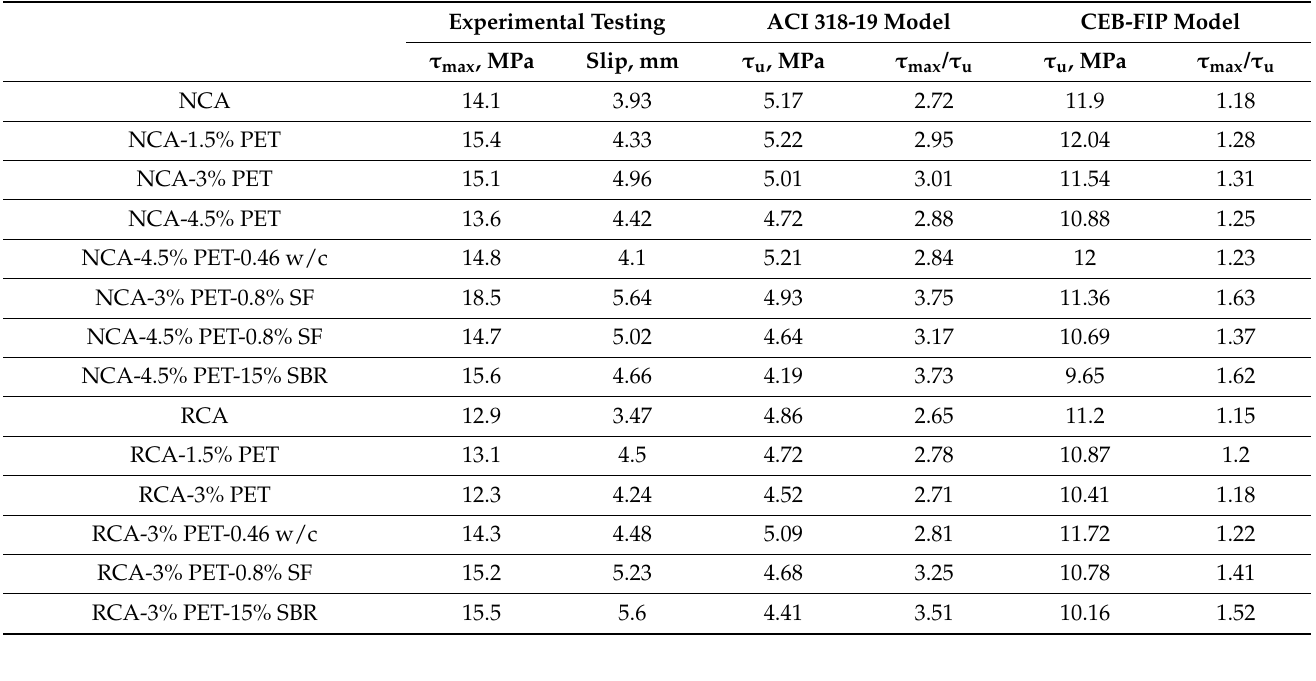
Table 3. Concrete bond properties to embedded steel bars. Experimental Testing